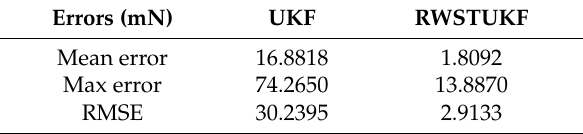
Table 1. Estimation errors by both UKF and RWSTUKF under the initial state estimation error. Errors (mN) UKF